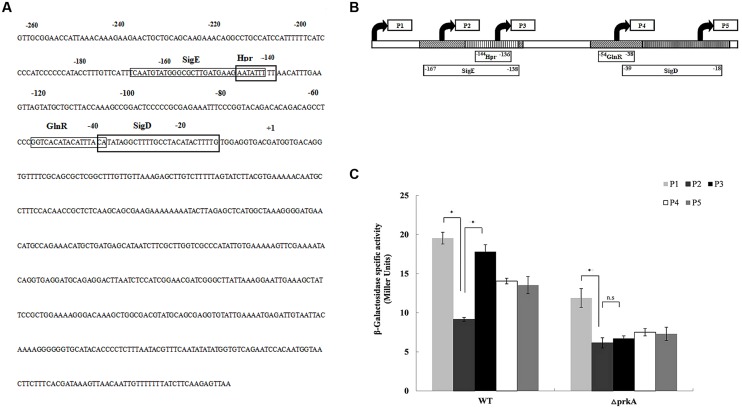
PrkA changes the expression of sigK via negatively regulating the transcription factor of Hpr (ScoC). (A) The sequence of the sigK promoter regions by 5′ deletions. The rectangle boxes indicate the binding motifs in the promoter of sigK including SigE, Hpr(ScoC), GlnR, and SigD. (B) Mapping of the sigK promoter regions by 5′ deletions. Schematic representation of the different sigK::lacZ fusions used in this study. The filled arrows indicate the primers used for generating the various reporter fusions (P1–P5). The blocks also indicate the binding motifs in the promoter of sigK including SigE, Hpr(ScoC), GlnR, and SigD, whereas the 5′ and 3′ end termini of the motifs are denoted with their nucleotide position relative to the initiator codon. The derivative strains of WT B. subtilis 168 or ΔprkA mutant carry the respective fusions are shown the below. (C) Expression of the series of sigK::lacZ fusions, respectively. Cells were grown in LB medium at 37°C, and β-galactosidase activities were determined at 36 h. The left histograms represent the derivative strains of the WT background; the right histograms represent the derivative strains of the ΔprkA mutant background. ∗P < 0.01; n.s represented no statistical significance.